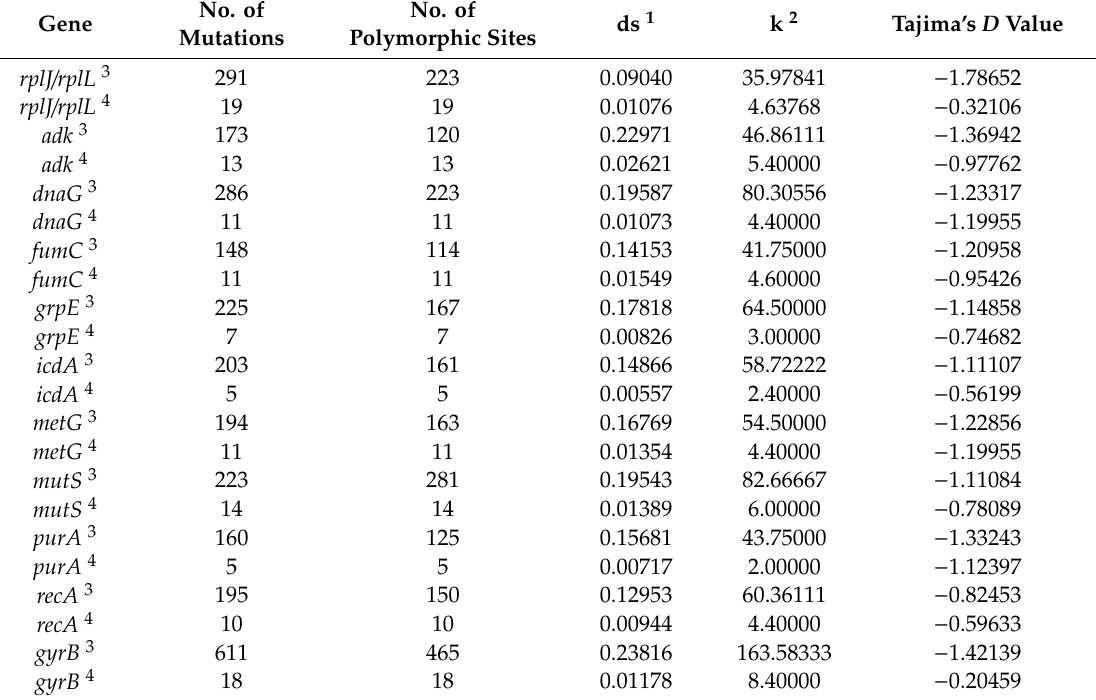
Table 5. Descriptive Analysis of Nucleotide Sequence Data for Each Housekeeping Gene on Liberibacter spp and CLso.